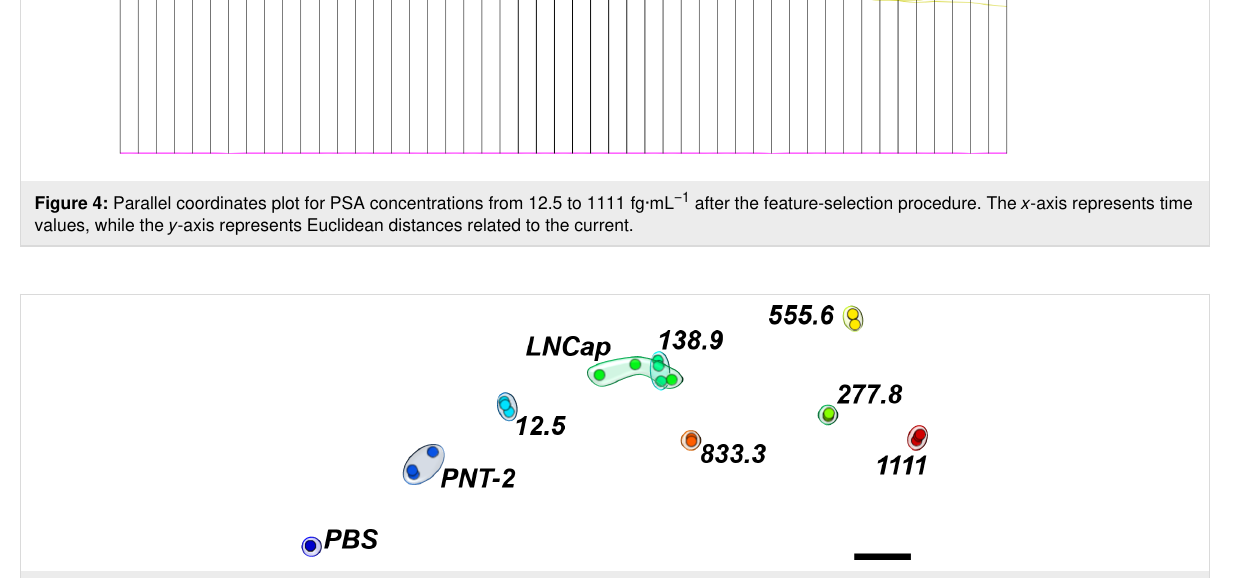
Figure 5: IDMAP plot obtained from the data in Figure 1A for buffers containing different PSA concentrations and from Figure 3 for prostate cancer cells. In both cases, feature selection was applied before plotting the